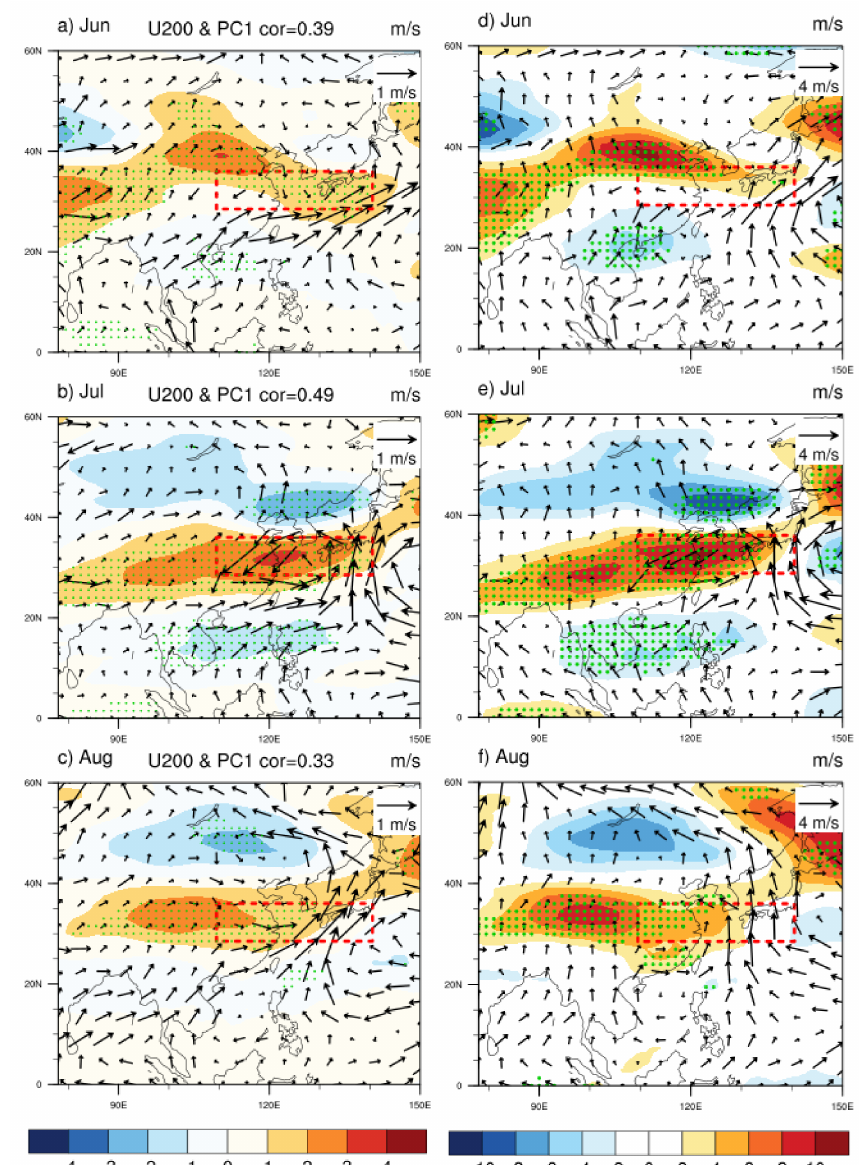
Figure 6. Regression maps ( a – c ) of 200 hPa zonal wind (shading) and 850 hPa winds (vectors) onto PC1. The difference maps ( d – f ) of the same elements between the five most positive years and the five most negative years in PC1. Stippled areas indicate 200 hPa zonal wind anomalies and differences that exceed the 90% confidence